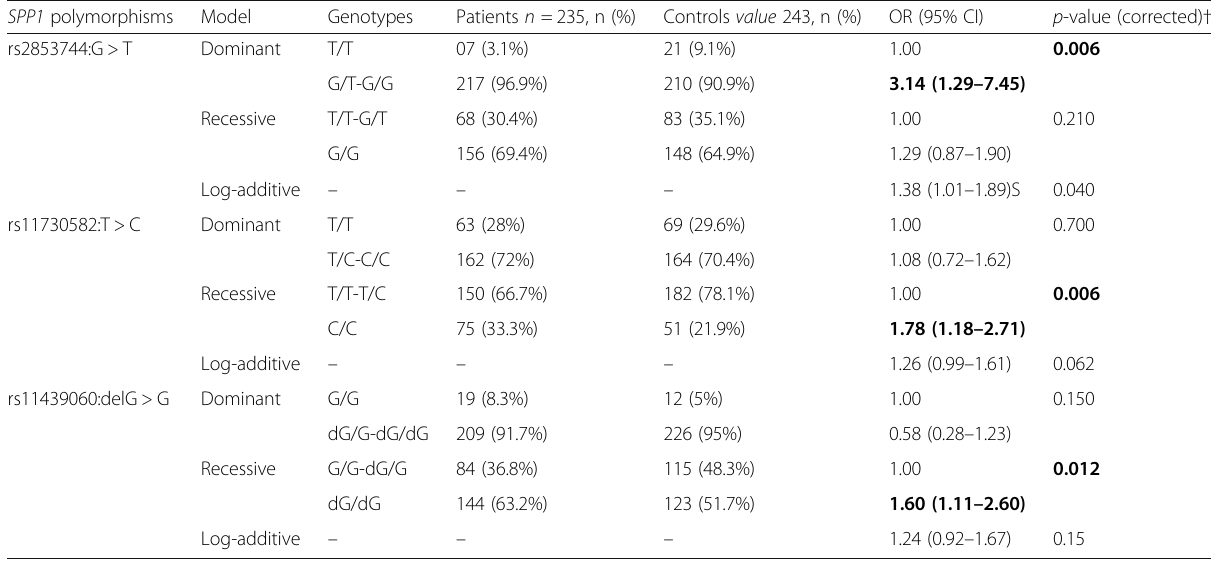
Table 2 Association analysis of urolithiasis risk and SPP1 genetic variants considering dominant, recessive and log-additive genetic